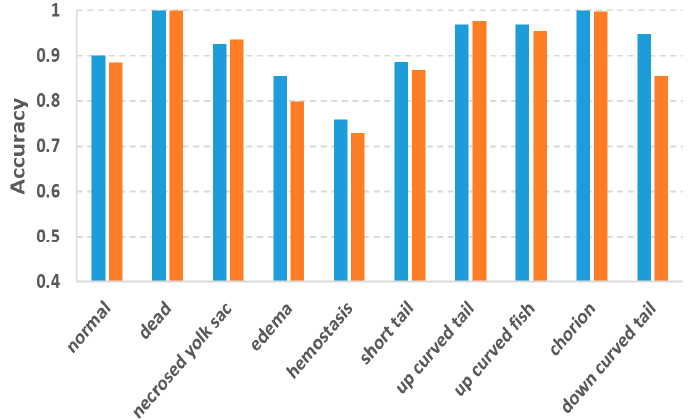
Figure 6. Comparison of classification accuracy between the two-tier and the single-tier pipelines.